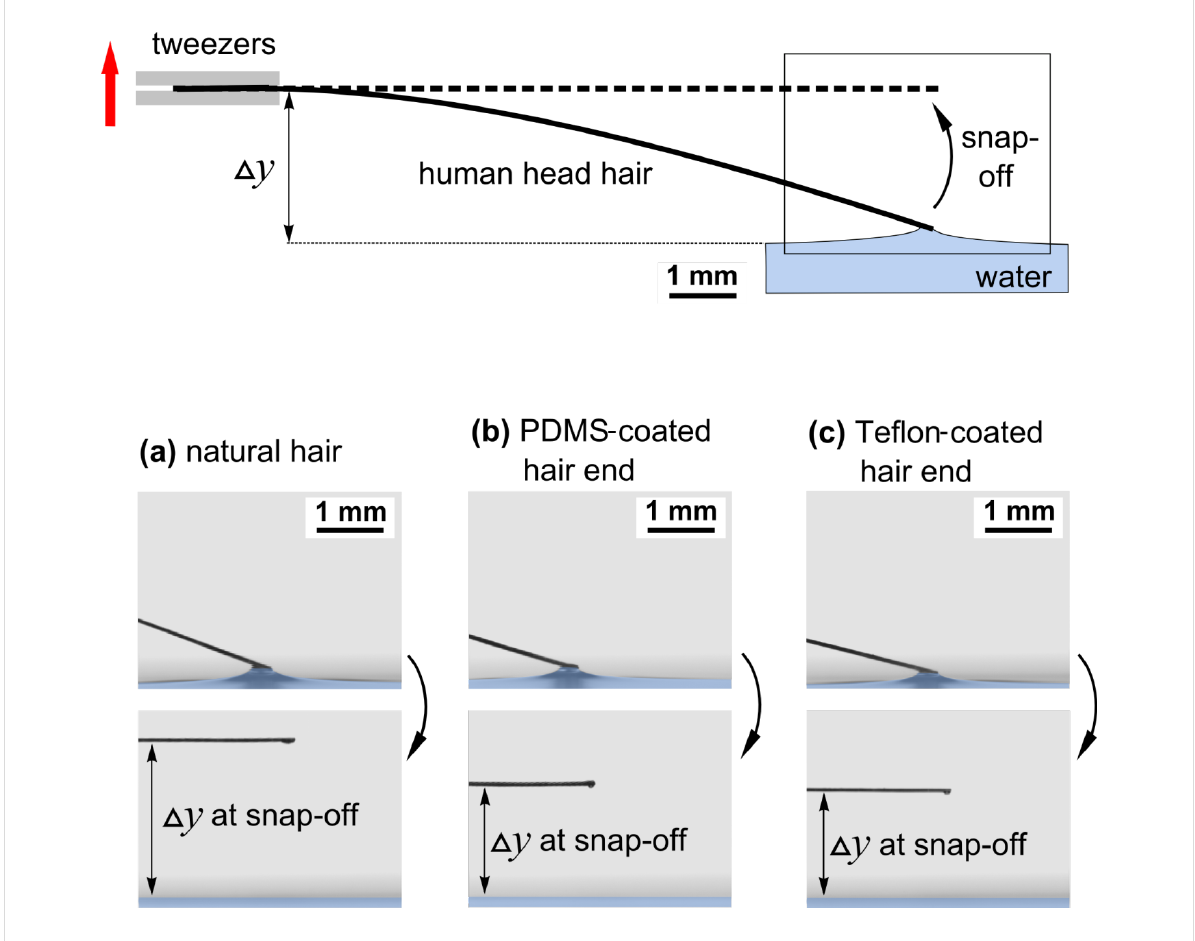
Figure 4: Examination of a human head hair. In this variation of the CAT, the hair is used as a bending spring. It is horizontally placed above the surface of the liquid in the tweezers and the bending before snap-off is measured with hair surfaces of different conditions (a) no coating (natural hair surface), (b) hair coated with teflon and (c) hair coated with silicone. Whereas the adhesion force depends on the coating, the elastic properties, such as the spring constant or Young’s modulus of the hair, remain unchanged by the coating.